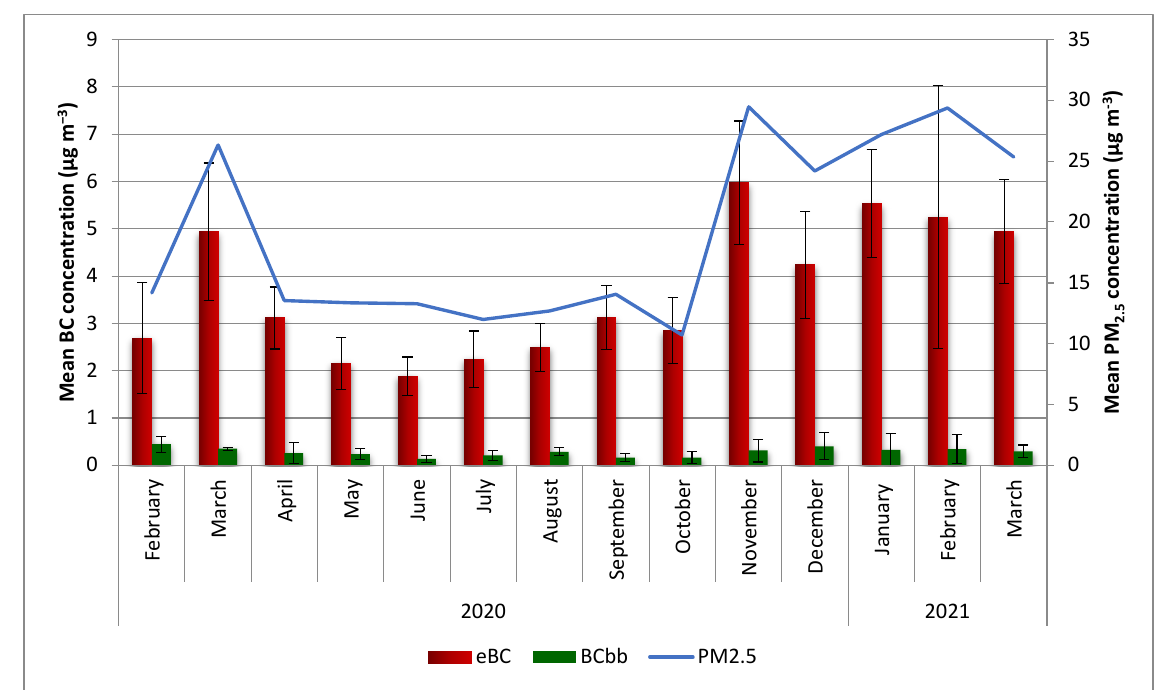
Figure 4. Comparison of daily concentrations between eBC and BC bb in µg m −3 and temperature in °C for sampling from Krakow during February 2020–March 2021. The values of temperature were taken from the webpage: http://meteo.fis.agh.edu.pl/ (accessed on 8 December 2021)–“created by author”. for the PM2.5 fraction at a Liverpool site with values in the range of 0.2–6 µ g m − 3 [20]. The exposed filter from 25 February 2021 (25-02-2021 in Figures 4) was the blackest, Kebe et al. measured an eBC concentration value equal to 3.6 ± 0.5 µ g m − 3 for the PM2.5 which is visually evident when compared with all exposed filters, and this is a confirma- fraction for 2018/2019 at Dakar in Senegal [21]. tion of the highest eBC values for that day.